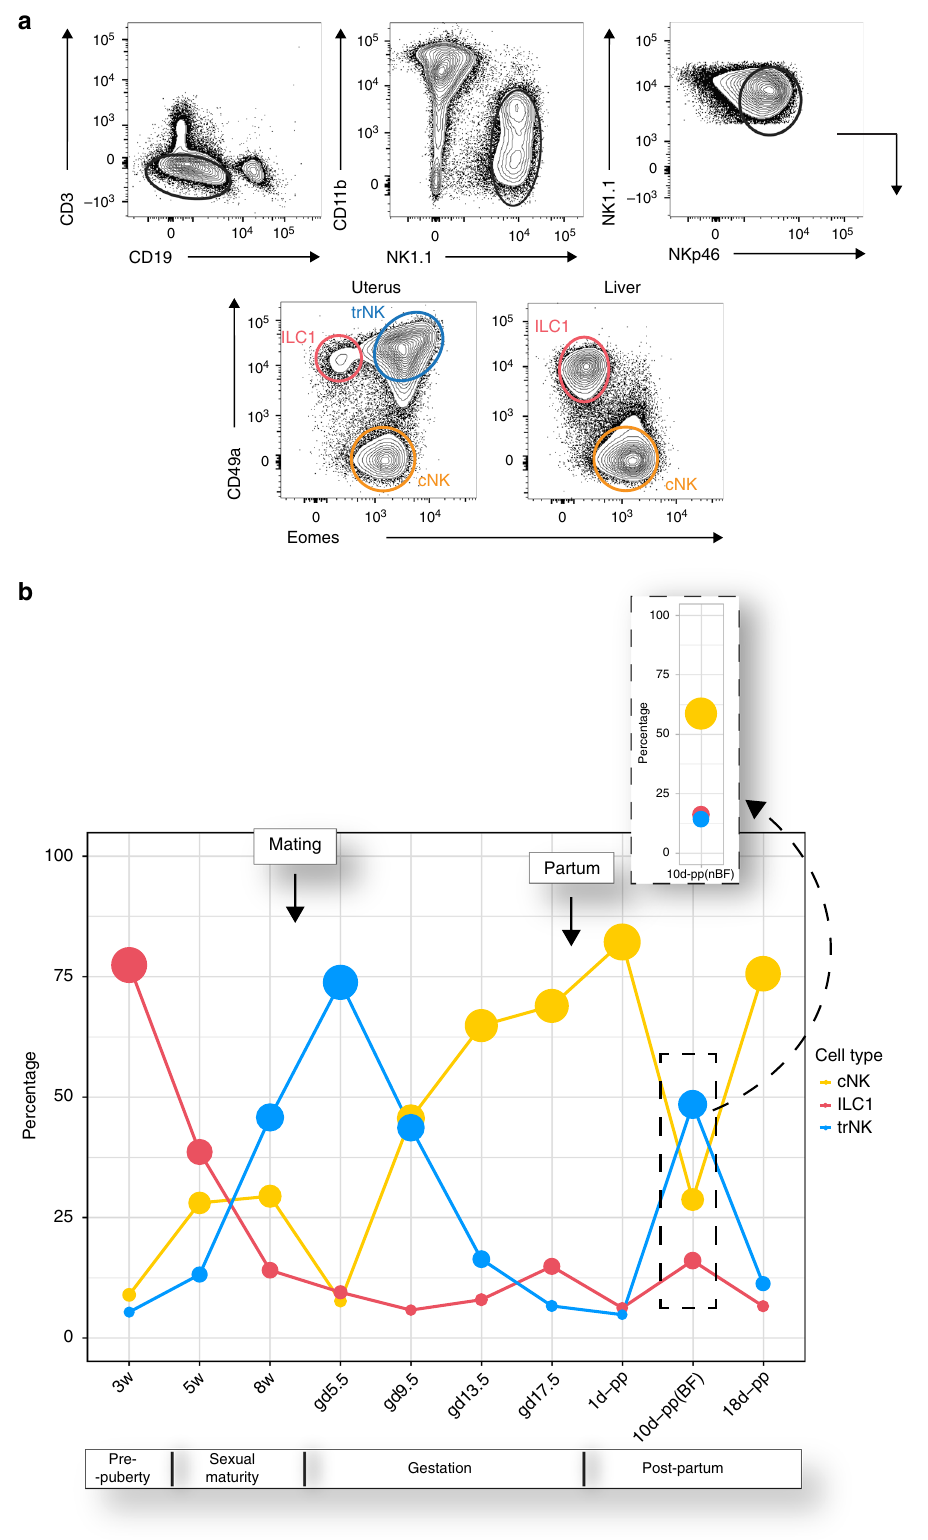
cells (Fig. 2a). Hierarchical clustering using the differentially expressed genes with a log2 fold change cutoff of 7.5 and p -value <0.01 con fi rmed that uterine and hepatic ILC1s cluster apart (Fig. 2b), despite phenotypic similarities (ref. 14 and Fig. 1a). The expression of Tbx21 (T-bet), Eomes , Ifng , Itga1 (CD49a), Itga2